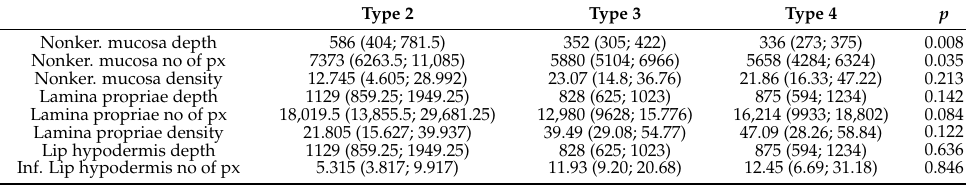
Table 3. HFU assessment of lower lip mucosa according to skin phenotype.